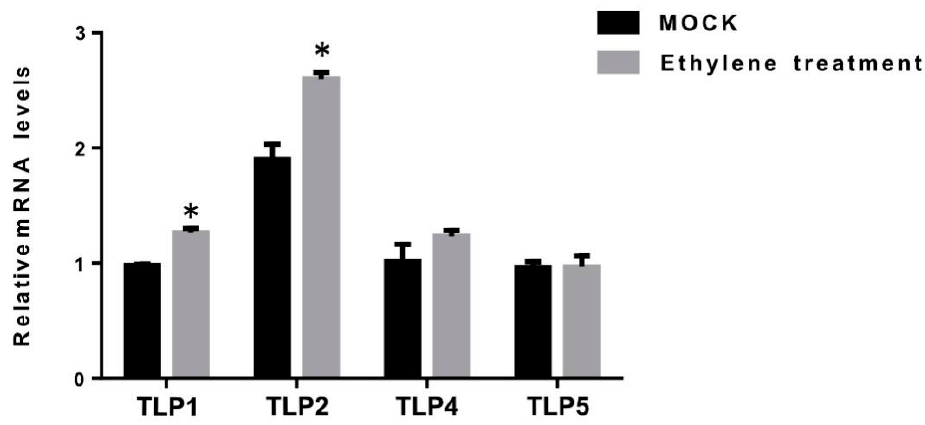
Figure 7. Expression of TLP1 , TLP2 , TLP4 , and TLP5 under ethylene treatment (MOCK: mature green stage fruit without ethylene treatment; Ethylene treatment: mature green fruit treated with ethylene for 30 min. The values represent the means of three biological replicates. *, p < 0.05 (Student’s t -test).).